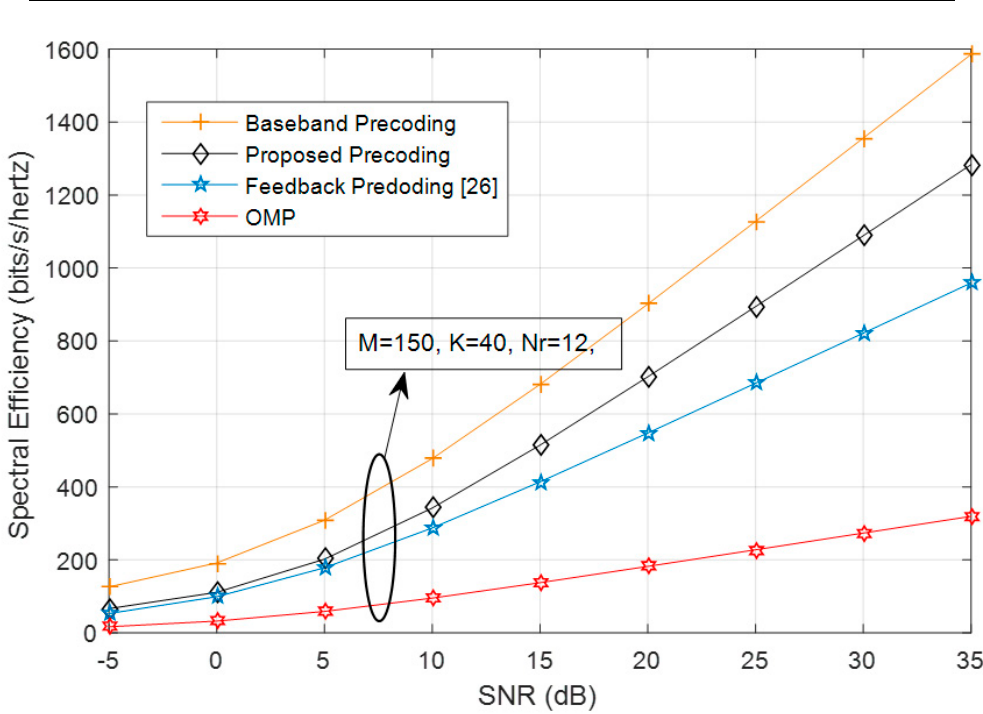
Figure 3. Spectral e ffi ciency and the comparison between the proposed and reference